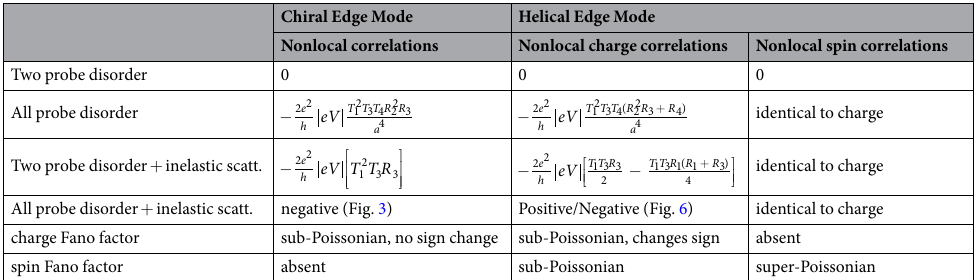
Table 1. Topological Helical vs. Topological Chiral edge modes via non-local HBT